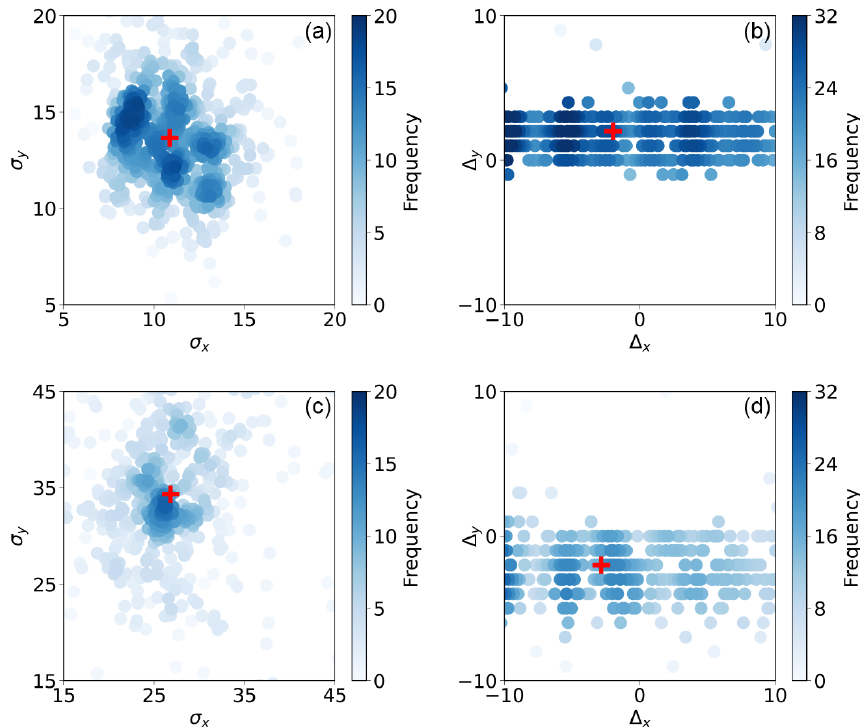
Figure E5. The density scatter plots of solved PSF parameters, σ (a, c) and (cid:49) (b, d) in x and y direction for L8 (a, b) and S2 (c, d) , where the red markers stand for the median of those parameters. The units of the x and y axis are the number of